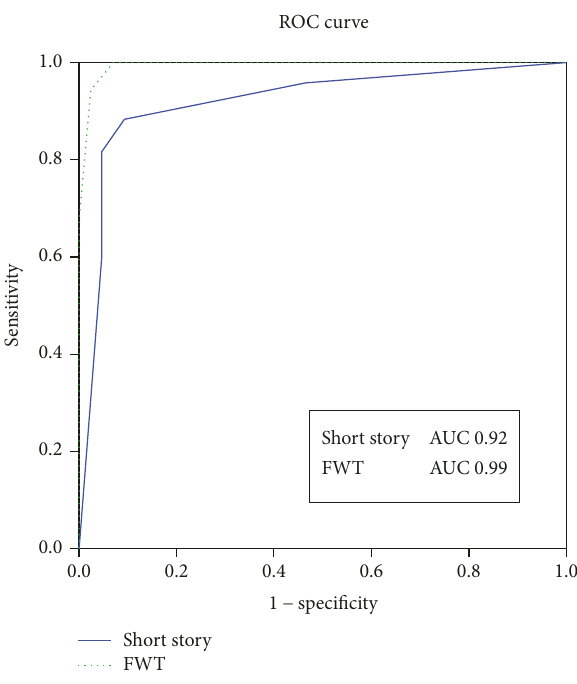
Figure 2: Receiving operating characteristic (ROC) curves of the short story equivalent score and the fi ve-word test (FWT) total score: discrimination of Alzheimer ’ s disease from healthy subjects. AUC indicates the area under the